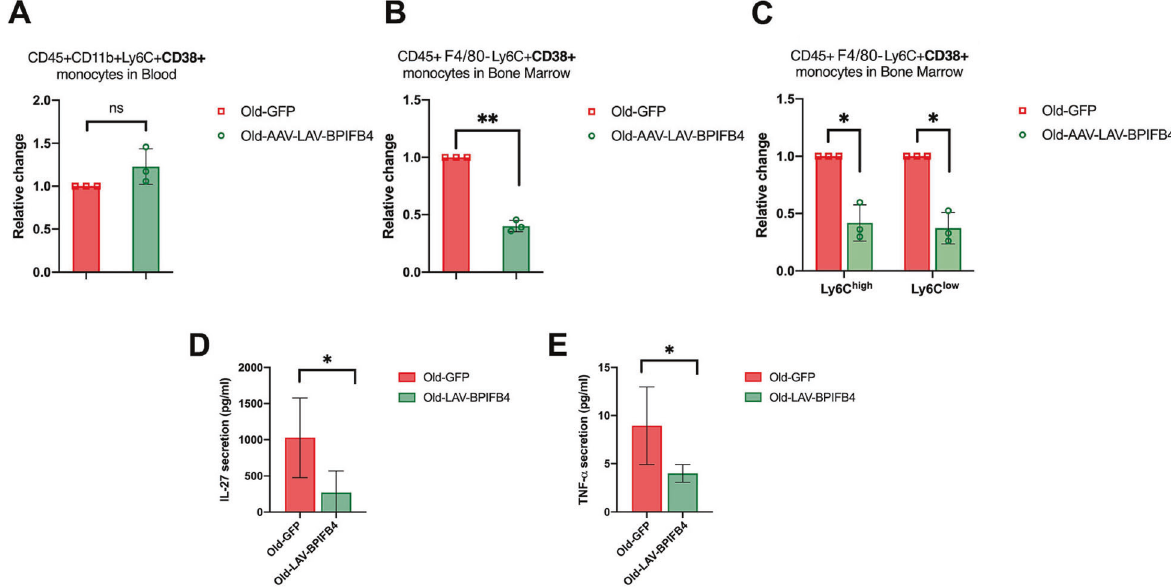
Fig. 5 AAV-LAV-BPIFB4 tunes lower CD38 expression in aged blood and bone marrow monocytes shaping an anti-in fl ammatory microenvironment. Blood and bone marrow monocytes in n = 3 Old-GFP mice and n = 3 Old-AAV-LAV-BPIFB4 mice were interrogated by fl ow cytometry gating on CD45 + F4/80-Ly6C + CD38 + cells. Panels show A circulating monocytes and B bone marrow resident monocytes frequency in n = 3 Old GFP mice and n = 3 Old-AAV-LAV-BPIFB4 mice. C Histogram shows the amounts of CD45 + F4/80-Ly6C + CD38 + monocytes in bone marrow regarding the strati fi cation in Ly6C high and Ly6C low monocytes (* P < 0.05). Results are expressed as mean ± SD. Pairwise comparisons statistically signi fi cant are indicated (ANOVA; * P < 0.05, ** P < 0.01). Statistical evaluation was carried out by ordinary one-way ANOVA corrected for Tukey ’ s multiple comparisons test (GraphPad ® Prism). D IL-27 and E TNF- α secretion levels in bone marrow microenvironment of Old-GFP mice vs Old-AAV-LAV-BPIFB4 mice (* P < 0.05) expressed as mean ± SD. Statistical evaluation was carried out by ordinary one-way ANOVA corrected for Tukey ’ s multiple comparisons test (GraphPad ®